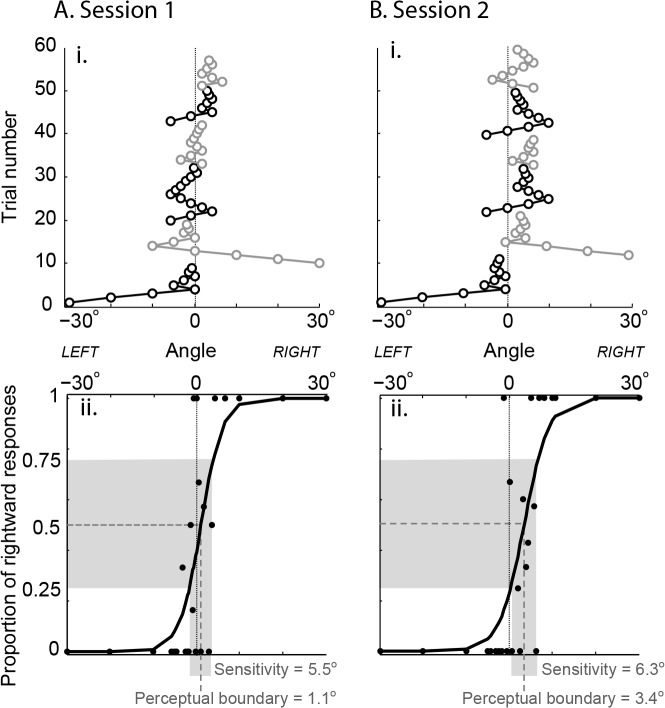
Adaptive staircase performance of a young subject (age 21) in two sessions conducted 10 days apart.
A. i. Subject performance on 6 staircases in session 1: trial number vs. angle of the white line relative to true index finger angle (0°). Black: staircases that began with a leftward trial. Grey: staircases that began with a rightward trial. ii. Proportion of rightward responses at each tested angle (black circles) with fitted function. Perceptual boundary (proprioceptive bias) was 1.1°, proprioceptive sensitivity (width of grey shaded area on x-axis) was 5.5°. B. i. Subject performance 10 days later on 6 staircases. ii. Both perceptual boundary and sensitivity (3.4° and 6.3°, respectively) appear similar to the first session.